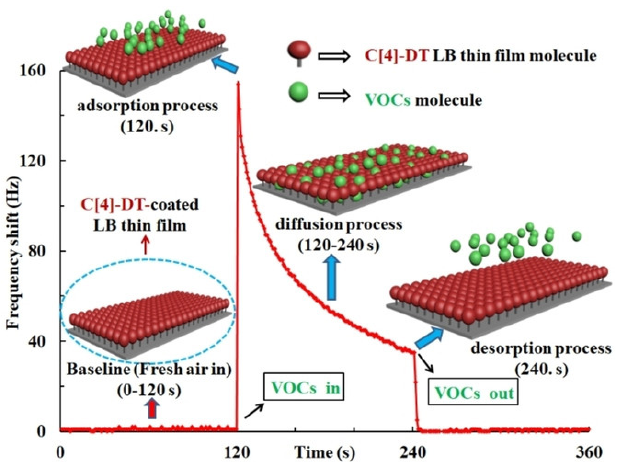
Figure 3. Schematic representation of the interaction of VOCs with the calix[4]arene-dithiourea receptor. Reprinted with permission from ref. [105]. Copyright 2021 Wiley.